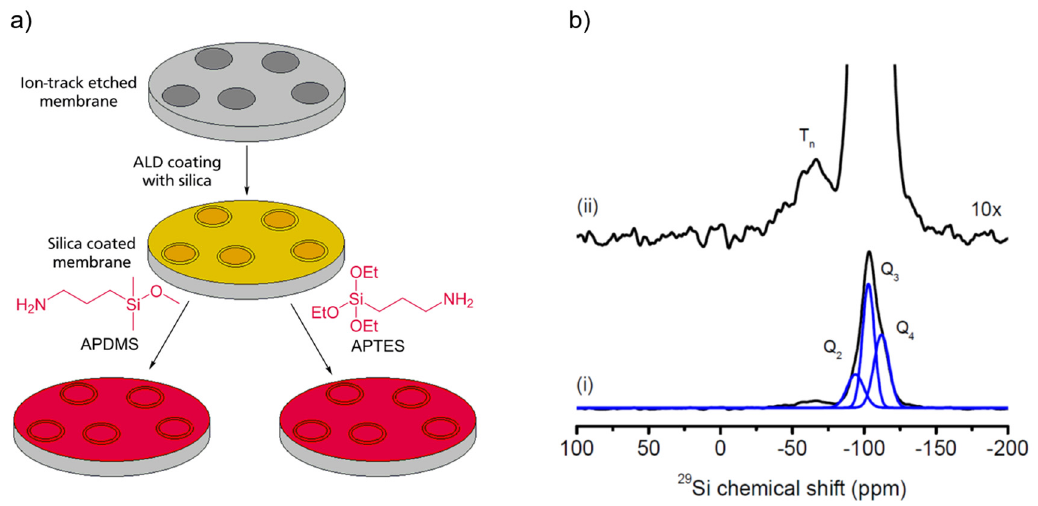
Figure 3. a ): Sketch of the three-step process to synthesize amine functionalized silica coated porous polycarbonate-membranes (see text for details). ( b ): DNP enhanced 29 Si CPMAS spectra (i) polycarbonate-membranes (see text for details). b ): DNP enhanced 29 Si CPMAS spectra (i) revealing